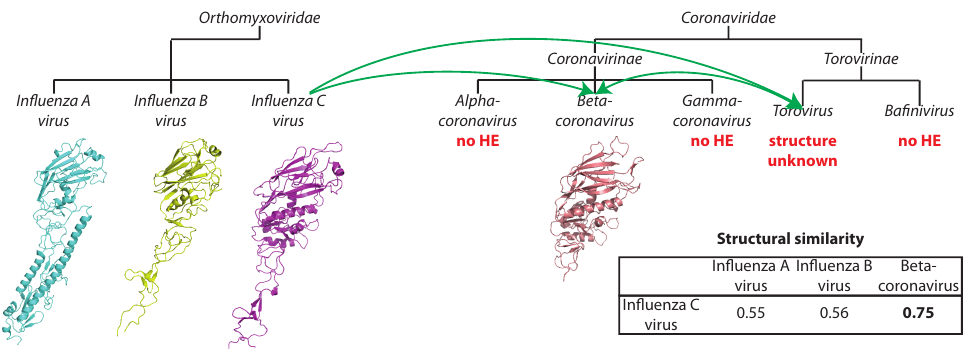
Figure 5. Potential route of horizontal gene transfer of hemagglutinin-esterase (HE) from Orthomyxoviridae to Coronaviridae . Structural similarity is reported as